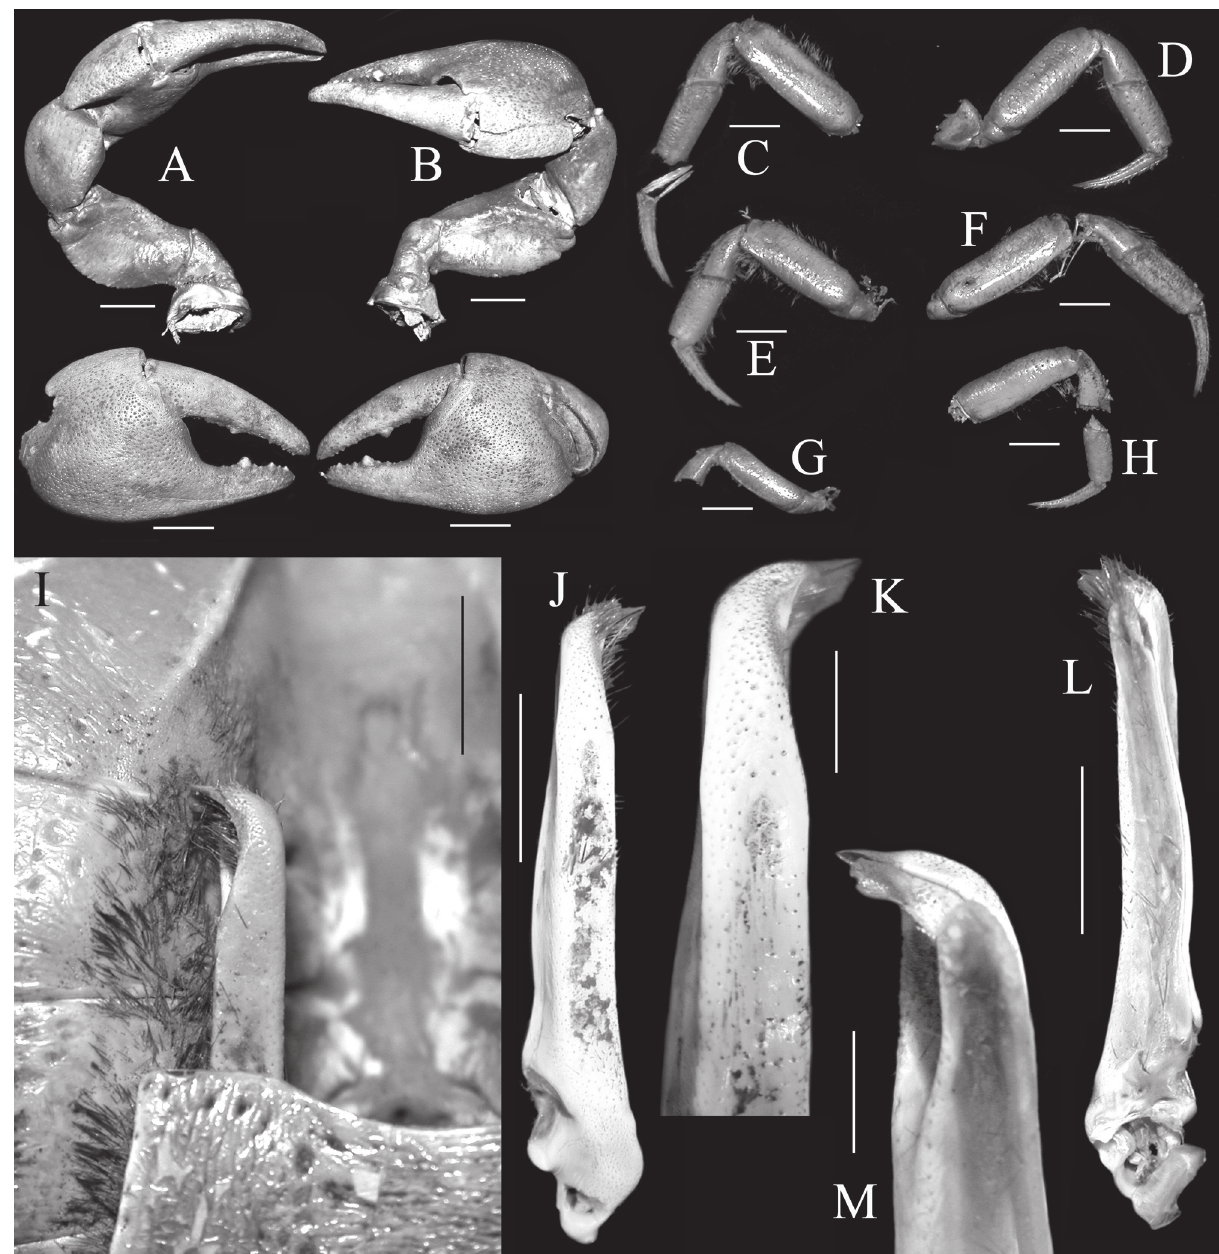
Figure 3. Cardisoma hirtipes Dana, 1851, lectotype male (58.2 × 47.4 mm) (USNM 2356). A, dorsal view of left cheliped; B, dorsal view of right cheliped; C, outer view of right chela; D, outer view of left chela; C, left first ambulatory leg; D, right first ambulatory leg; E, left second ambulatory leg; F, right second ambulatory leg; G, left fourth ambulatory leg; H, right third ambulatory leg; I, sternoabdominal cavity with intact right G1; J, ventral view of left G1; K, distal half of left G1, ventral view (denuded); L, dorsal view of left G1; M, distal half of left G1, dorsal view (denuded). Scale bars: A–H = 10.0 mm; I, J, L = 5.0 mm; K, M = 2.0